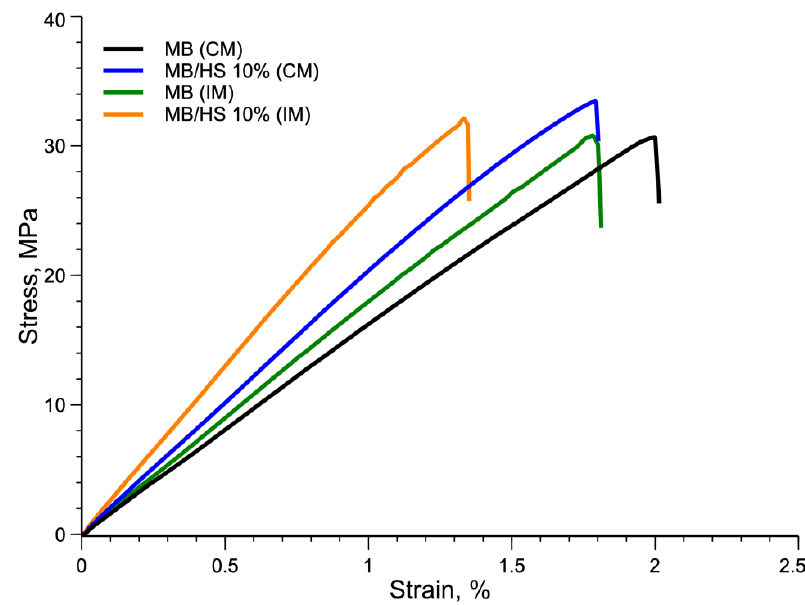
Figure 12. Compression- and injection-molded samples’ stress–strain curves. Table 4. Impact